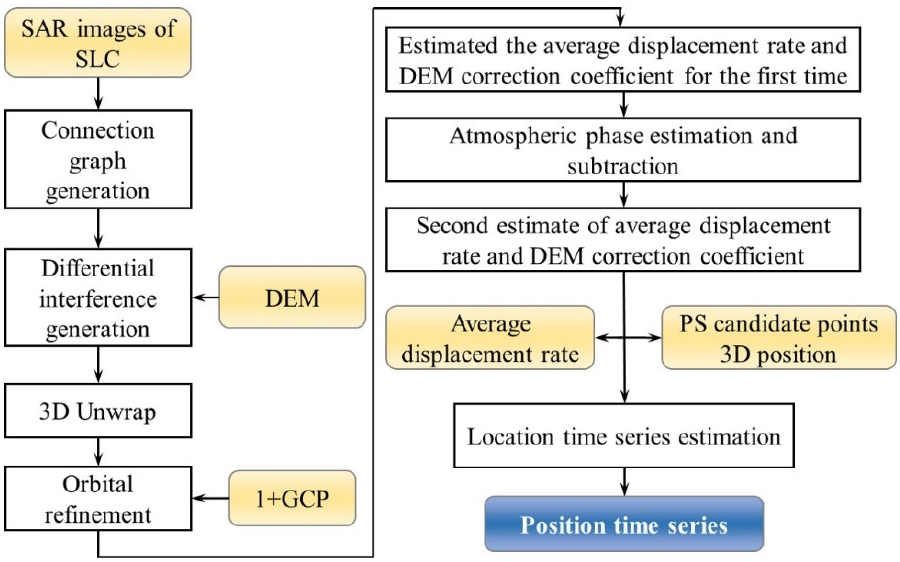
Figure 10. Processing flow of the SBAS-InSAR technique.